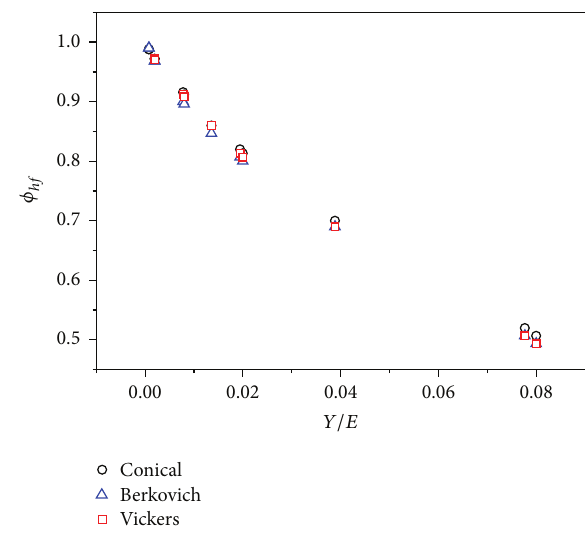
Figure 7: The variation of dimensionless function 𝜙 ℎ𝑓 = ℎ 𝑓 /ℎ max with respect to 𝑌/𝐸 for different kinds of